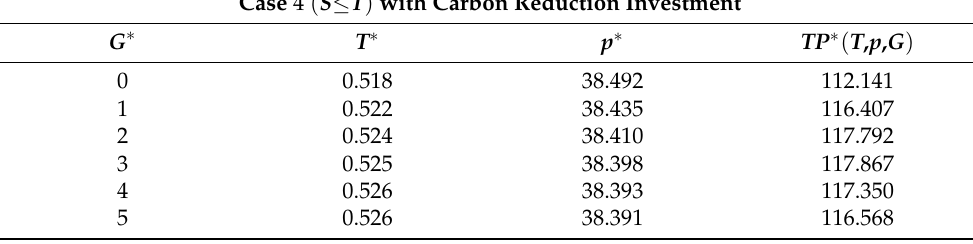
Table 4. Solution algorithm for case 4 to find G ∗